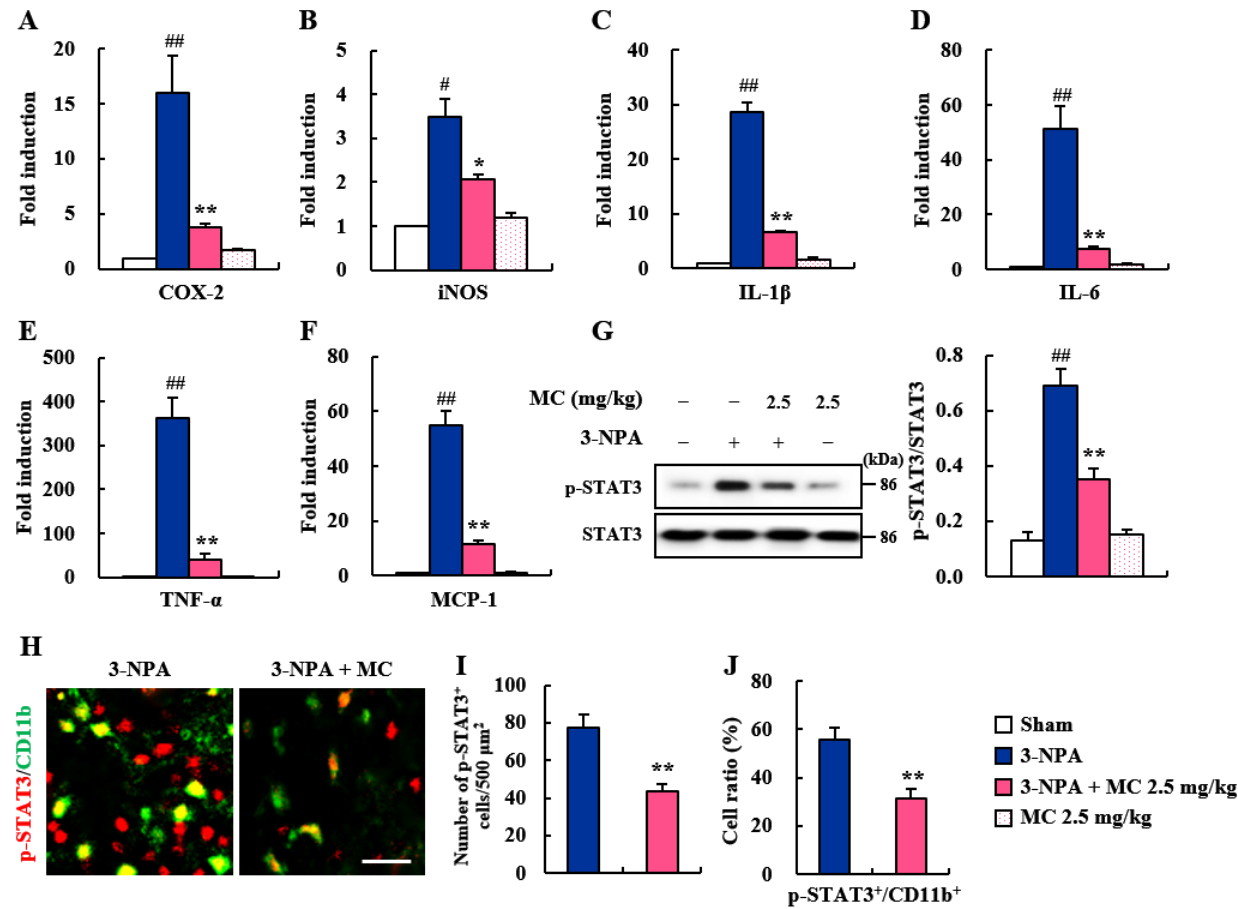
Figure 4. MC reduces the mRNA or protein expression levels of inflammatory factors and p-STAT3 in striatum or microglia after 3-NPA treatment. ( A – F ) Twelve hours after the last (5th) 3-NPA-treatment, striatal tissues from sham ( n = 5), 3-NPA ( n = 5), 3-NPA + MC (2.5 mg/kg/day; n = 5), and MC (2.5 mg/kg/day; n = 5) groups were analyzed by real-time PCR. MC reduced mRNA expression levels of representative inflammatory enzymes (COX-2 ( A ) and iNOS ( B )), cytokines (IL-1 β ( C ), IL-6 ( D ), and TNF- α ( E )), and chemokine (MCP-1 ( F )). ( G ) Twenty-four hours after the last (5th) 3-NPA-treatmentn, striatal laysats from all groups ( n = 5 group) were subjected to Western blot analysis. MC reduced protein expression of p-STAT3. Data are expressed as mean ± SEM (Kruskal– Wallis; # p < 0.05 and ## p < 0.01 versus sham group; * p < 0.05 and ** p < 0.01 versus 3-NPA group). ( H – J ) Twenty-four hours after the last (5th) 3-NPA-treatment, 3 striatal sections from all groups ( n = 5) were subjected to immunofluorescent staining using mixtures of p-STAT3/CD11b antibodies. Red, green, and yellow colors show p-STAT3 + , CD11b + , and p-STAT3 + /CD11b + , respectively ( H ). The numbers of p-STAT3 (+) cells per 500 µ m 2 and the ratio of CD11b (+) cells containing p-STAT3 (+) signal were measured ( I , J ). MC reduced p-STAT3-immunoreactivity in the striatum and CD11b (+) cells. Scale bar = 200 µ m. Data are expressed as mean ± SEM (Kruskal–Wallis; ** p < 0.01 versus 3-NPA